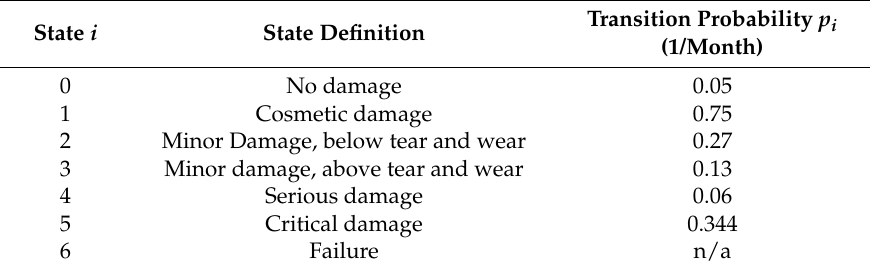
Table 2. States of the degradation process and transition probabilities, based on